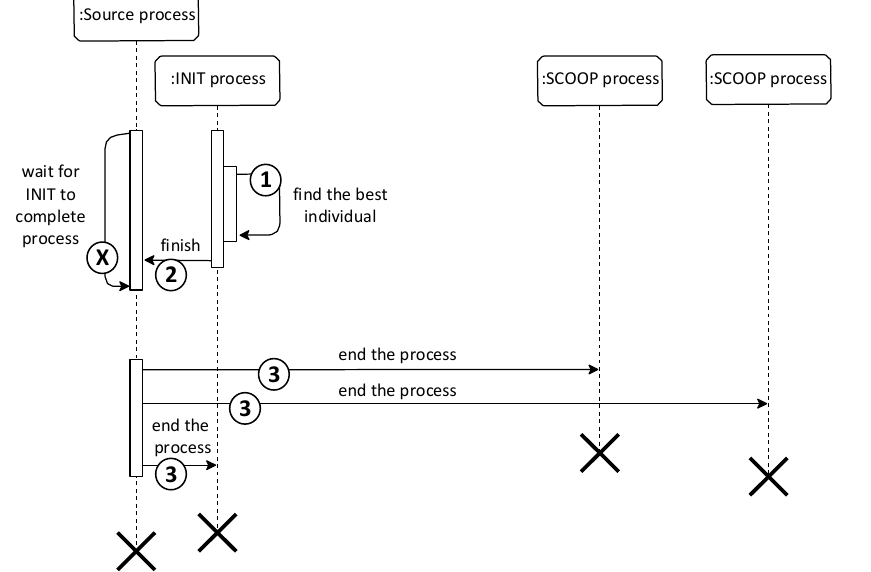
Figure 3. Sequence Master–Slave module termination diagram for 3